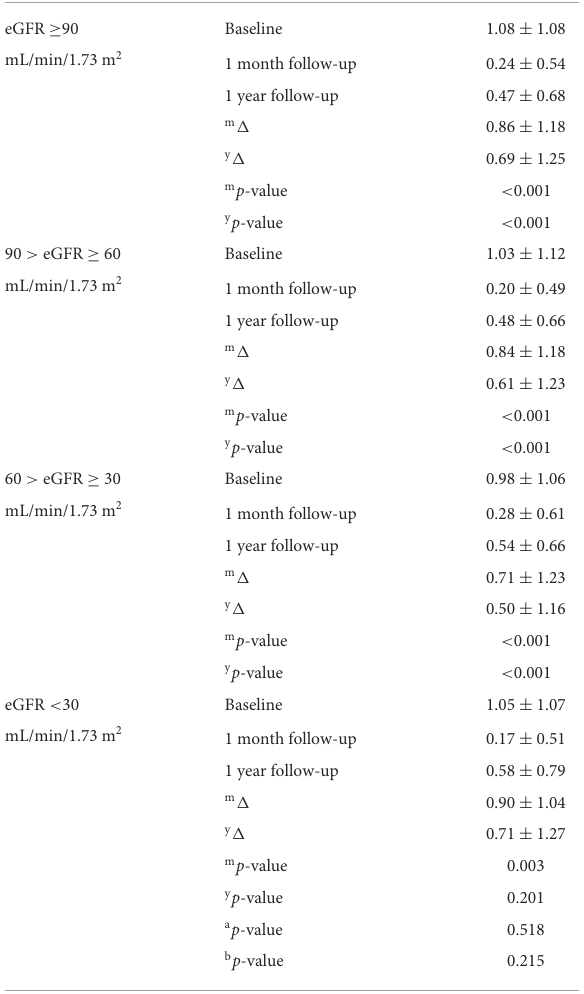
TABLE 5A Comparison of changes in RDS from baseline to